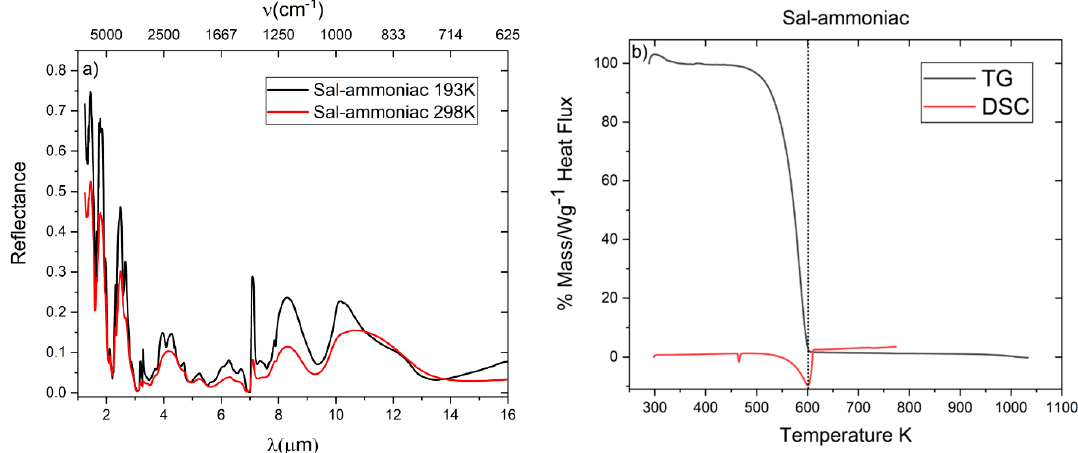
Figure 10. Reflectance spectra at room temperature and 193 K ( a ) and TG / DSC ( b ) analysis from room temperature to 773 and 1023 K of